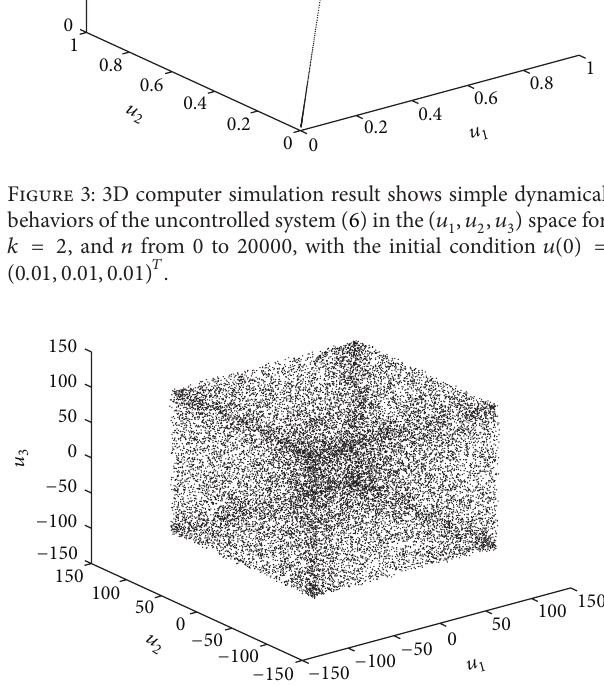
Figure 4: 3D computer simulation result shows complex dynamical behaviorsofthecontrolledsystem(7)inthe (𝑢 1 ,𝑢 2 , 𝑢 3 ) spacefor 𝛼 = 100 , 𝛽 = 100 𝜋 , 𝑘 = 2 , and 𝑛 from 0 to 20000, with the initial con- dition 𝑢(0) = (0.01, 0.01, 0.01) 𝑇